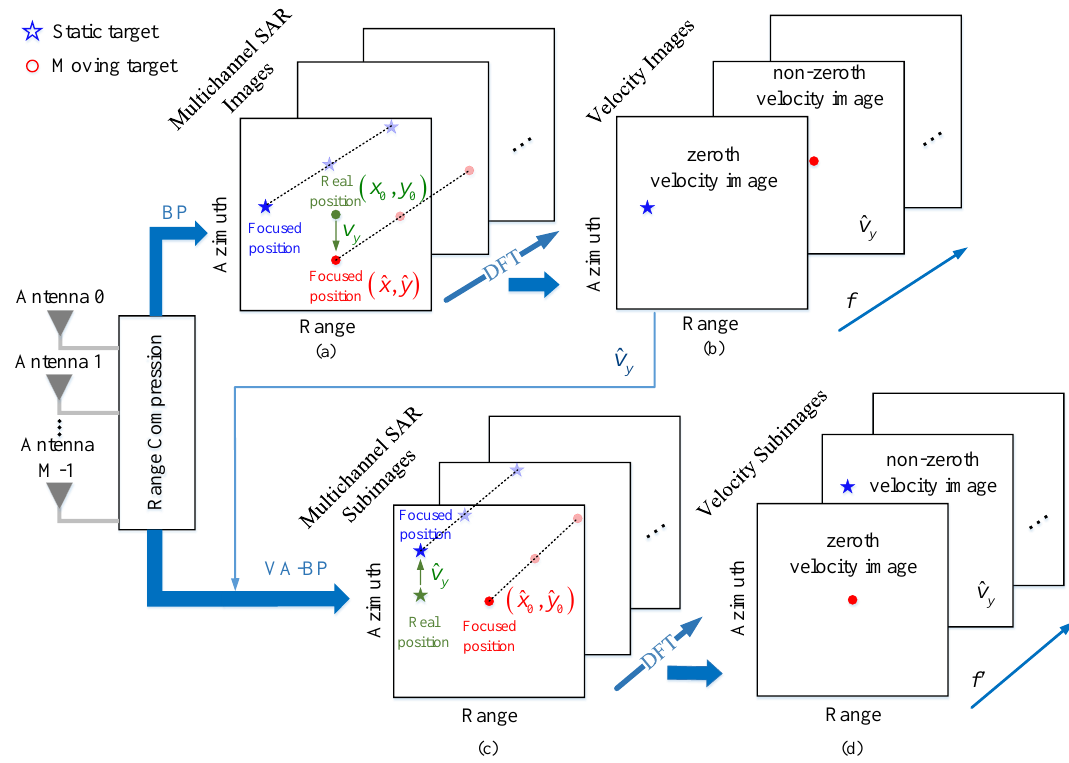
Figure 2. SAR images of different methods. ( a ) Multichannel SAR images via the BP algorithm. ( b ) Velocity images. ( c ) Multichannel SAR subimages via the velocity-aided (VA)-BP algorithm. ( d ) Velocity